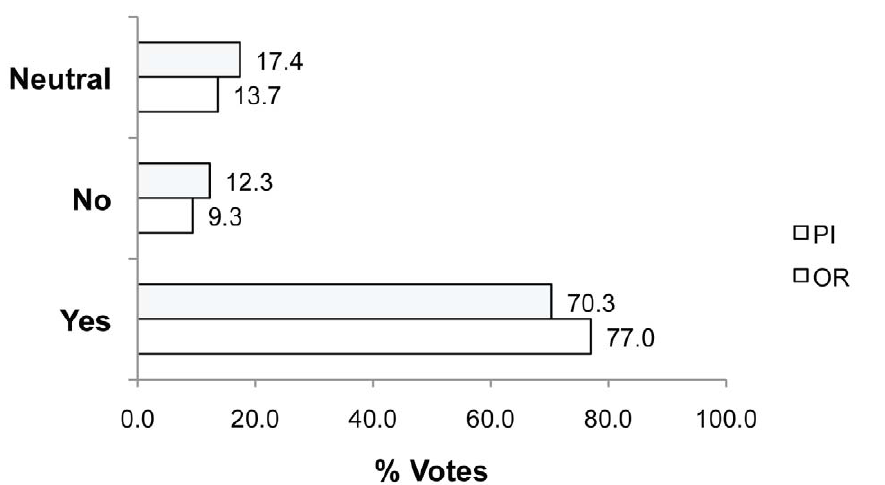
Figure 8. Percent of Yes, No and Neutral votes in response to Q6. Question 6: Would you consider conducting an animal welfare-related pilot study prior to, or in parallel with your main research?